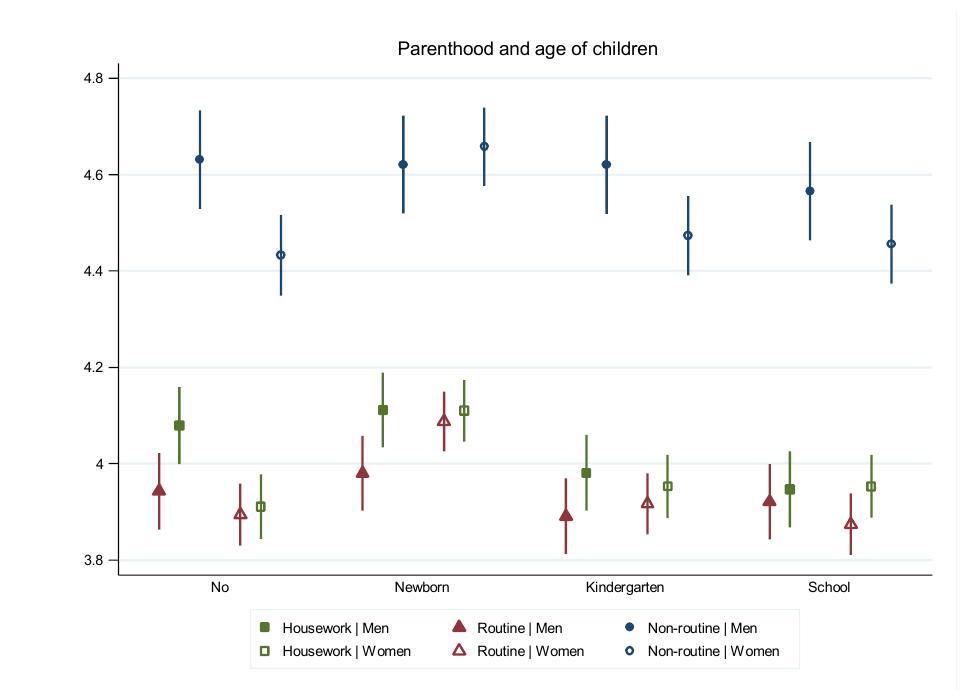
Figure B.2 : Predicted attitudes towards housework by vignette couples’ parental